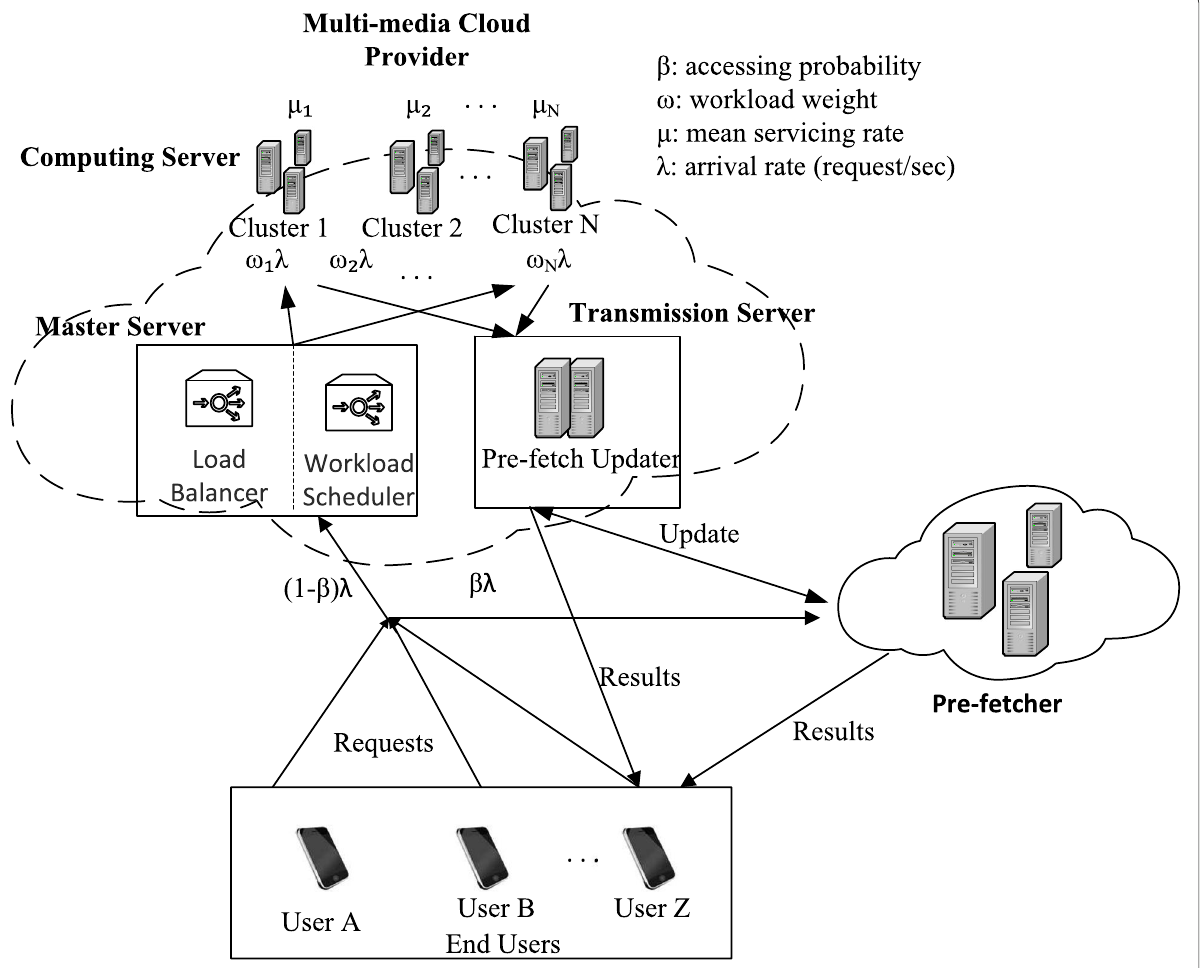
Fig. 1 Data transmission between cloud and end users in the presence of